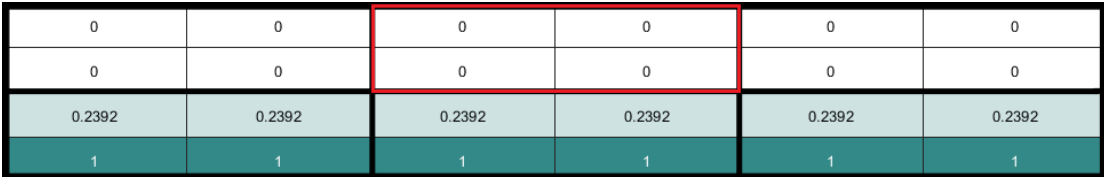
Figure 11. Heatmap with signboard as obstacle (second obstacle).